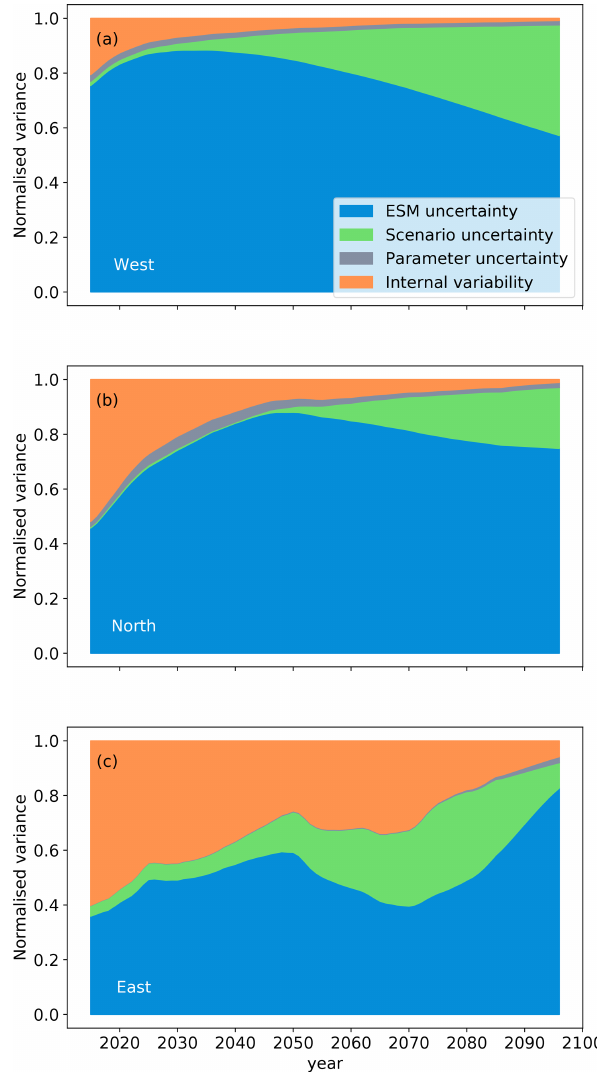
Figure 8. Relative variances of the different uncertainty compo- nents for three different regions of the GrIS: uncertainty associ- ated with the choice of ESM (blue), uncertainty caused by differ- ent emission scenarios (green), uncertainty of different parameter combinations of the snow model (grey), and internal variability (or- ange), being the variance of the residues of a fourth-degree polyno- mial fit to the decadal mean integrated SMB. The calculations are described in Appendix C. The time period does not extend to 2100 because the variance splitting approach is applied to the decadal running means of the yearly